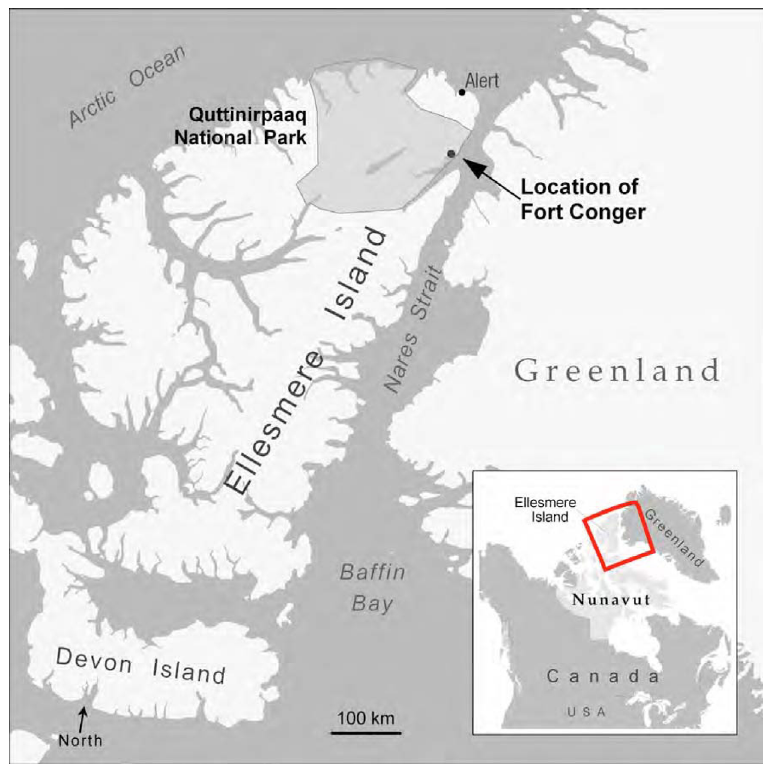
Figure 1. Location of Fort